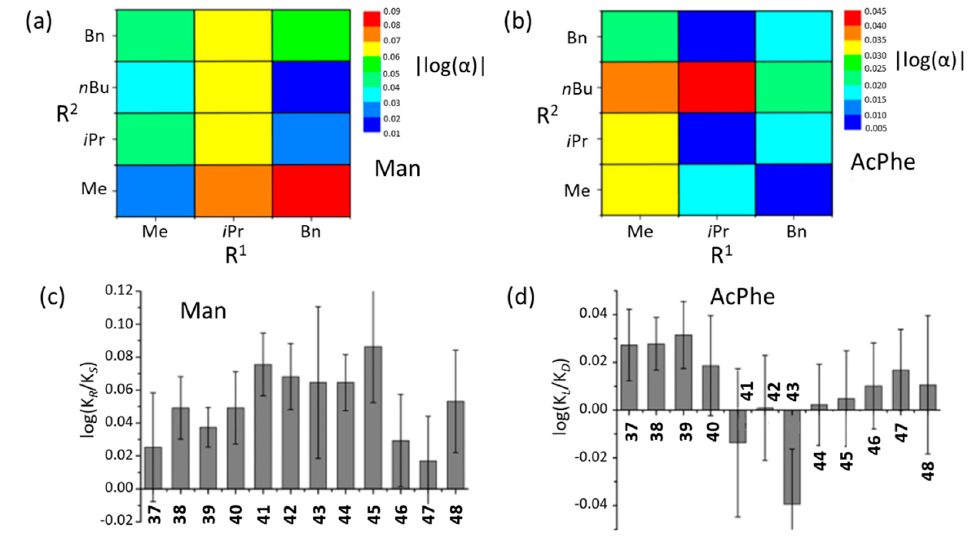
Figure 15. ( a , b ) Enantioselectivity distribution (log( α )) of receptors with mandelates and acetylated phenylalanines; ( c , d ) graphical analysis of the effect of R 1 and R 2 groups on the enantioselectivity of receptors with mandelates and acetylated phenylalanines.